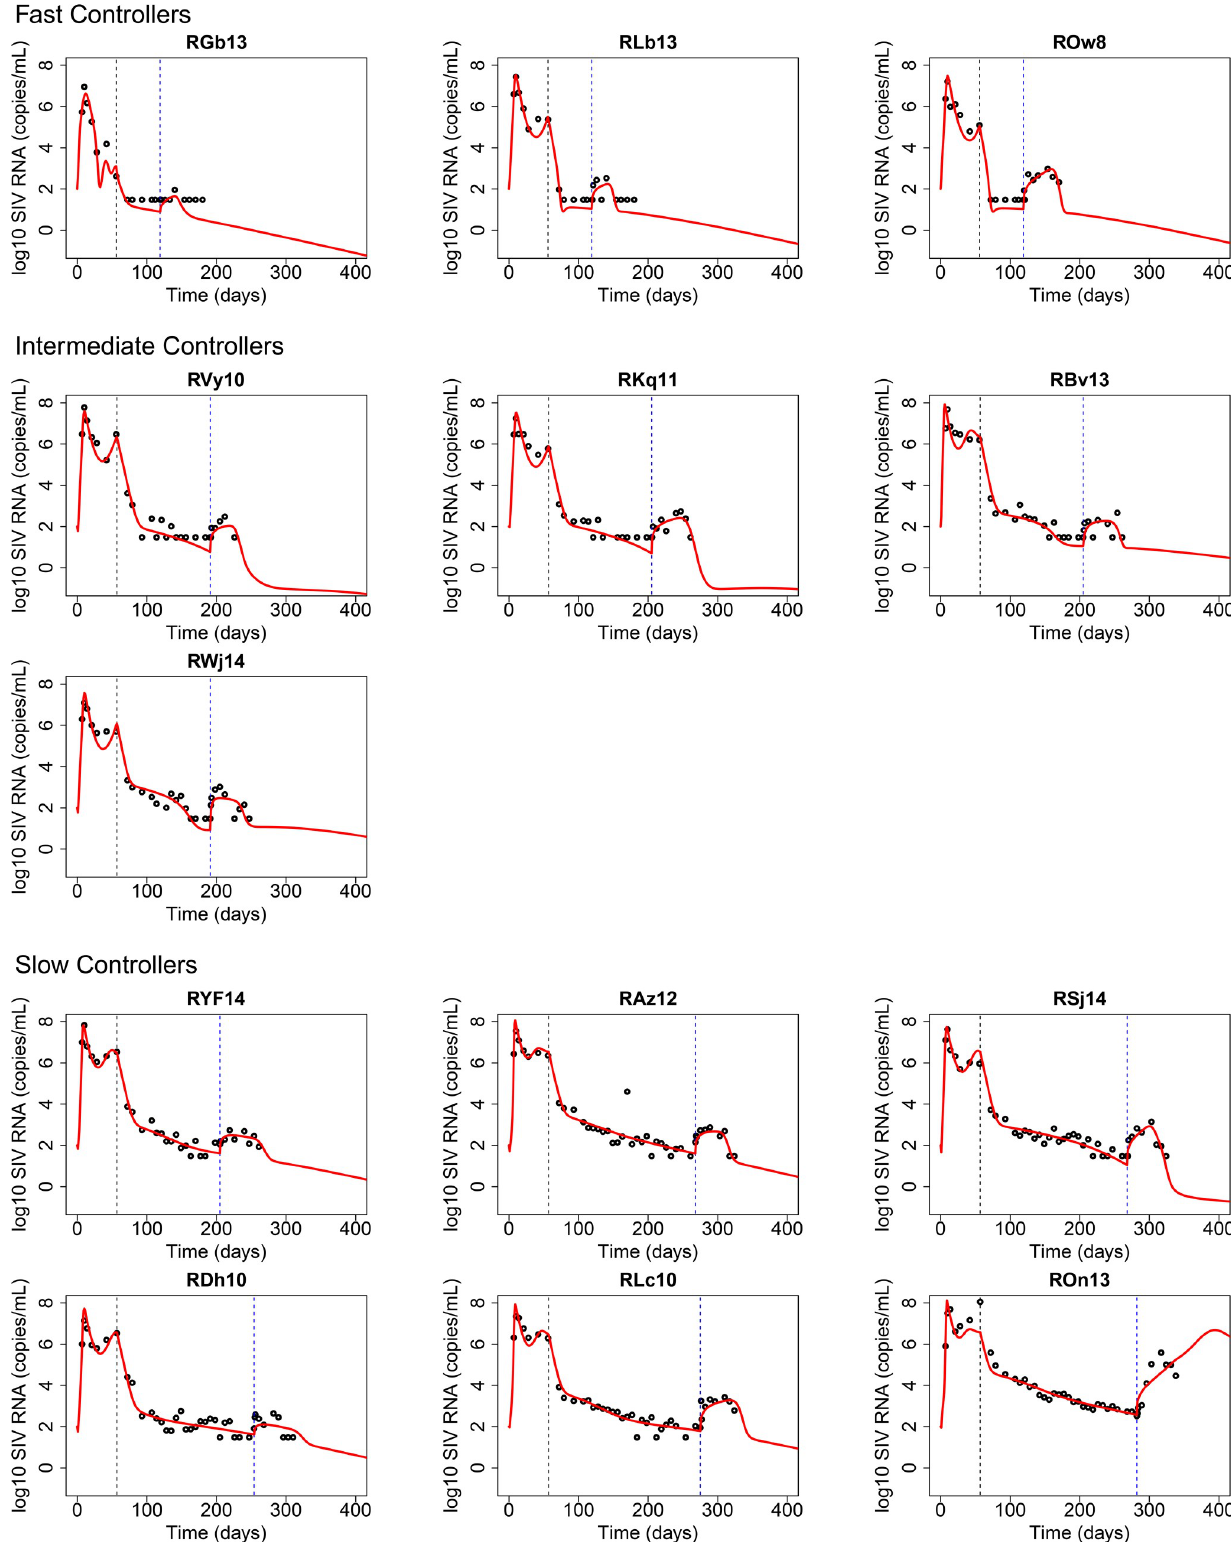
Fig 2. Fits of the CTL-VC model (red lines) to the VL data (black dots). The first vertical dashed line indicates the start time of ART, and the second vertical dashed line indicates the start time of anti-CD8 antibody. https://doi.org/10.1371/journal.ppat.1007350.g002 PLOS Pathogens| https://doi.org/10.1371/journal.ppat.1007350 October 11,